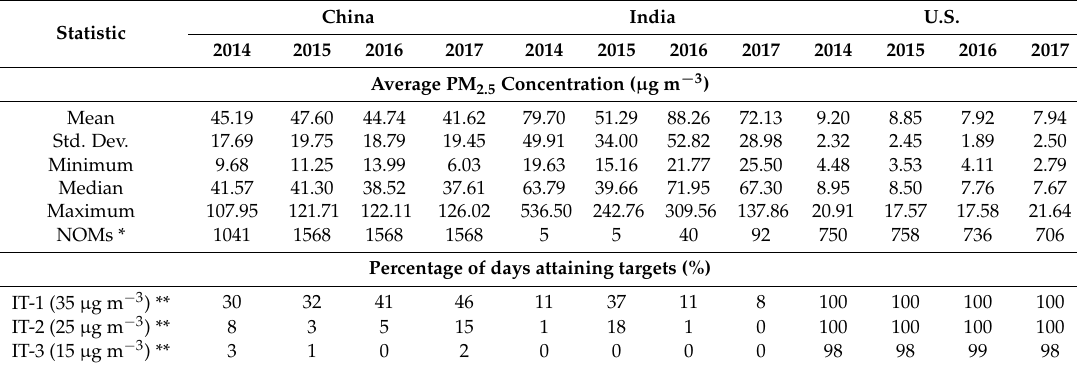
Table 1. Summary of daily PM 2.5 concentrations in China, India, and the U.S. China Statistic